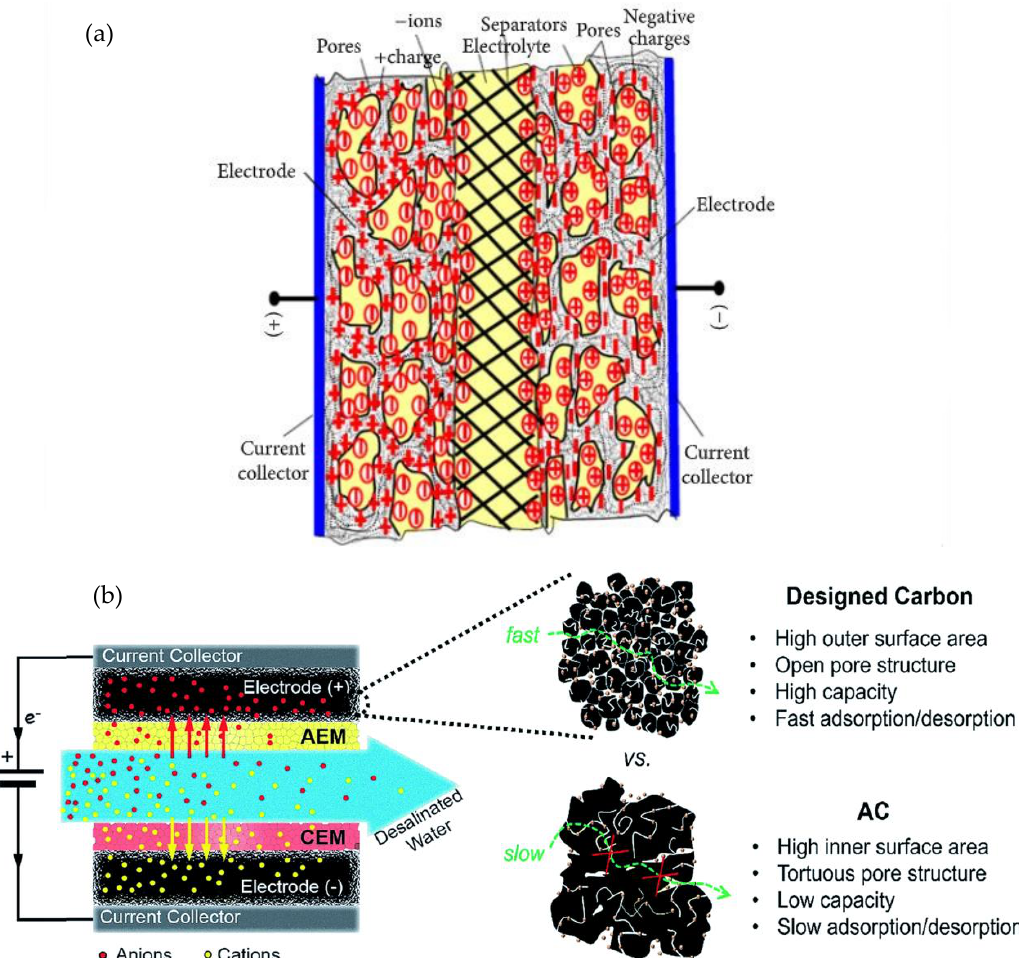
Figure 5. ( a ) Schematic illustration of a charged supercapacitor based on porous electrodes. Reprinted from [62] copyright (2008), with permission from Elsevier. ( b ) Design criteria of high-performance porous carbon materials. Used with permission of Royal Society of Chemistry (Great Britain), from [63] copyright 2013; permission conveyed through Copyright Clearance Center, Inc.